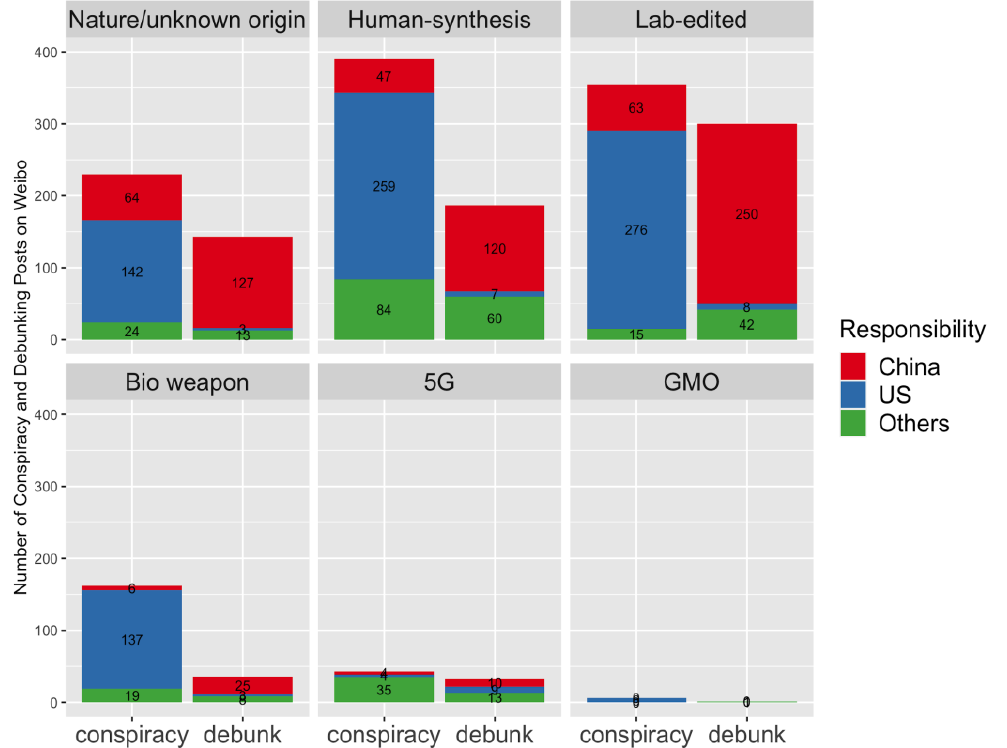
Figure 1. Number of conspiracy and debunking posts by Covid-19 origins type and responsibility attribution . Finding 2: Conspiracies that blamed the United States for COVID-19 surged following Sino-U.S.